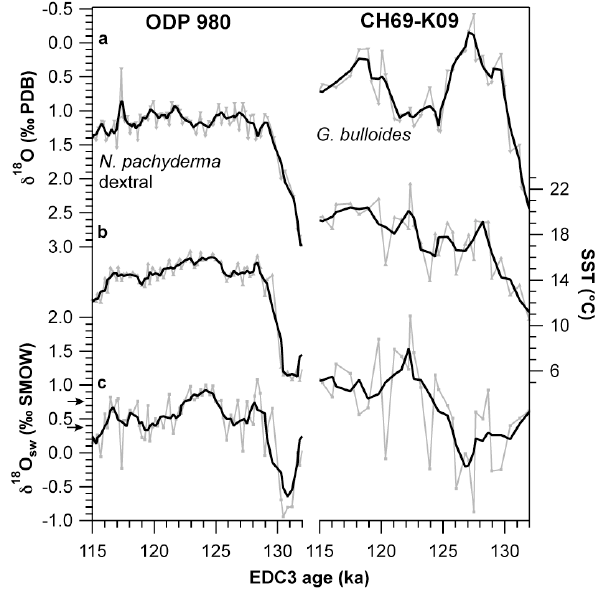
Figure 2: Reconstruction of seawater δ 18 O ( δ 18 O sw ) in cores ODP 980 (left panel) and CH69-K09 (right panel). For higher clarity, the records are shown versus age over the interval 115–132ka (see Sect. 3.1.1 and Fig. 5 for the definition of age models). (a) Planktic δ 18 O records from N. pachyderma dextral in core ODP 980 (Oppo et al., 2006) and G. bulloides in core CH69-K09 (Labeyrie et al., 1999). (b) Summer SST records (Labeyrie et al., 1999; Oppo et al., 2006). (c) Reconstructed seawater δ 18 O. The arrows along the Y-axis highlight the modern δ 18 O sw value at the site of core ODP 980 (0.38‰) and CH69-K09 (0.75‰) (Schmidt et al., 1999) (see Table 2). Grey lines show the raw data. Thick black lines are 3-point smoothing average for the planktic δ 18 O and SST records, and 5-point smoothing average for the δ 18 O sw